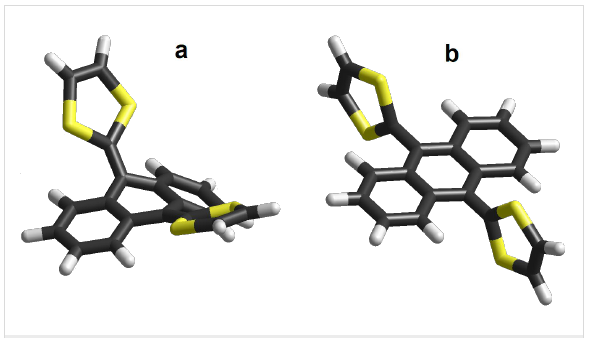
Figure 1: Depictions of 9,10-bis(1,3-dithiol-2-ylidene)-9,10-dihydro- anthracene (exTTF) in the (a) neutral form and (b) in the oxidized (2+) state. In the oxidized state the two positive charges reside on the two 1,3-dithiole